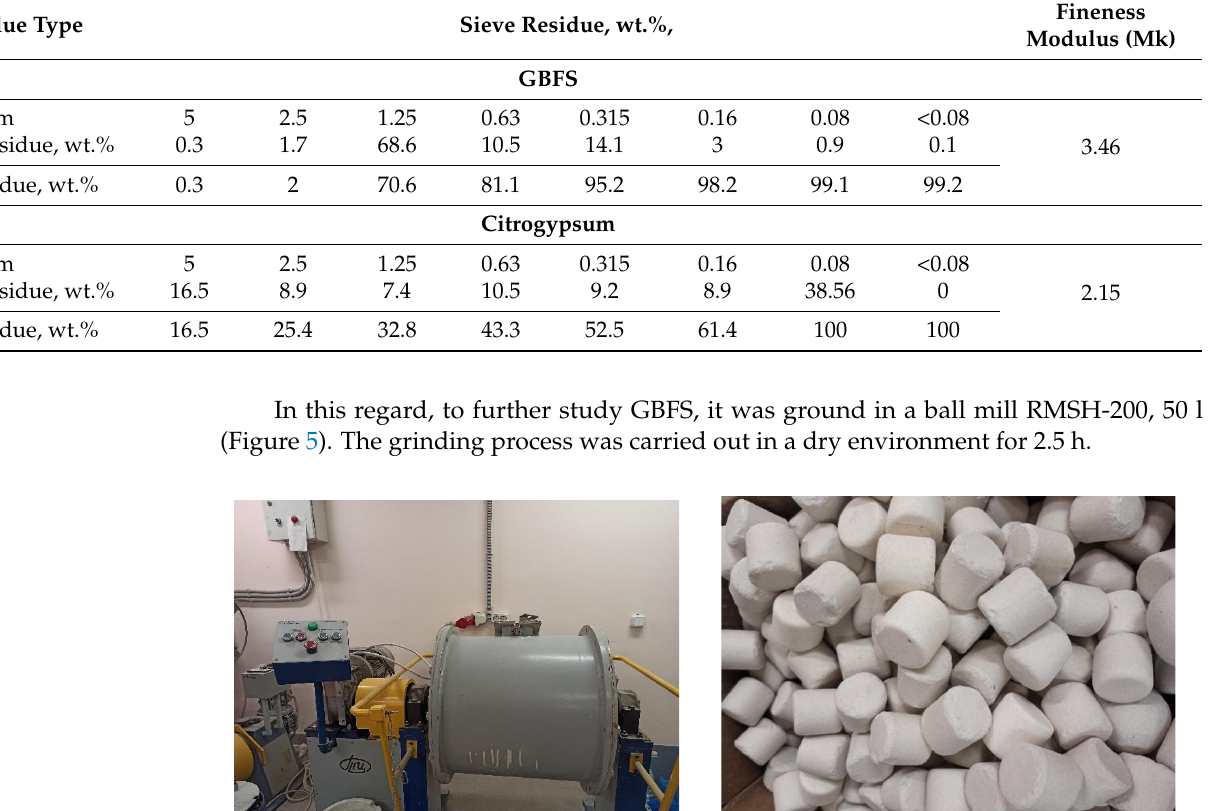
Figure 6. Granulometry of citrogypsum and ground GBFS.